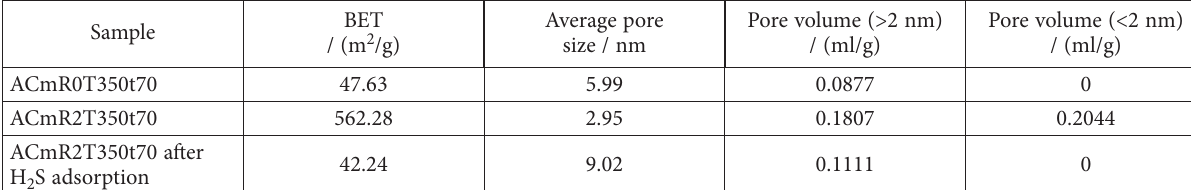
Table 1. The pore structure and BET of activated carbon samples before and after H 2 S adsorption BET Average pore Sample / (m 2 /g) size /